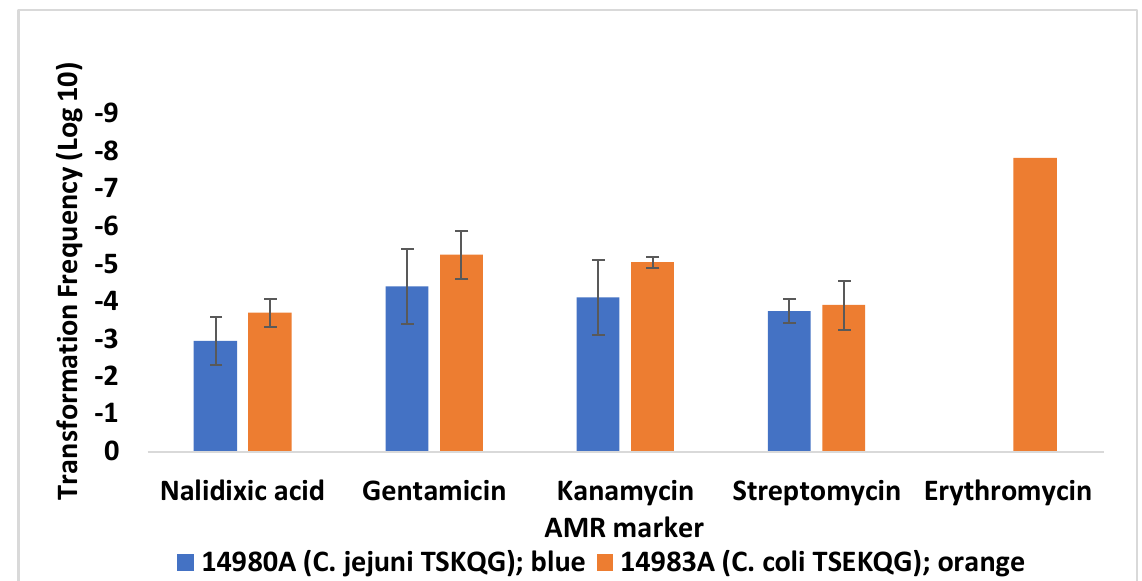
Figure 1. Transformation of C. jejuni SN:CM with DNA from C. jejuni 14980A and C. coli 14983A. Transformation frequencies are averages from two or more independent trials for each recipient strain–donor DNA pair. Letters within each AMR profile indicate resistance to streptomycin (S), gentamicin (G), kanamycin (K), erythromycin (E), or the quinolones nalidixic acid and ciprofloxacin (Q). No erythromycin-resistant transformants were obtained with DNA from C. coli 14983A ( C. jejuni 14980A is susceptible to erythromycin, hence was not used as source of donor DNA), and the transformation frequencies are below the limit of detection (<10 − 8 ). The error bar on the column with the transformation frequency data for erythromycin resistance was too small to be visible. Transformations were carried out as described in Materials and Methods.